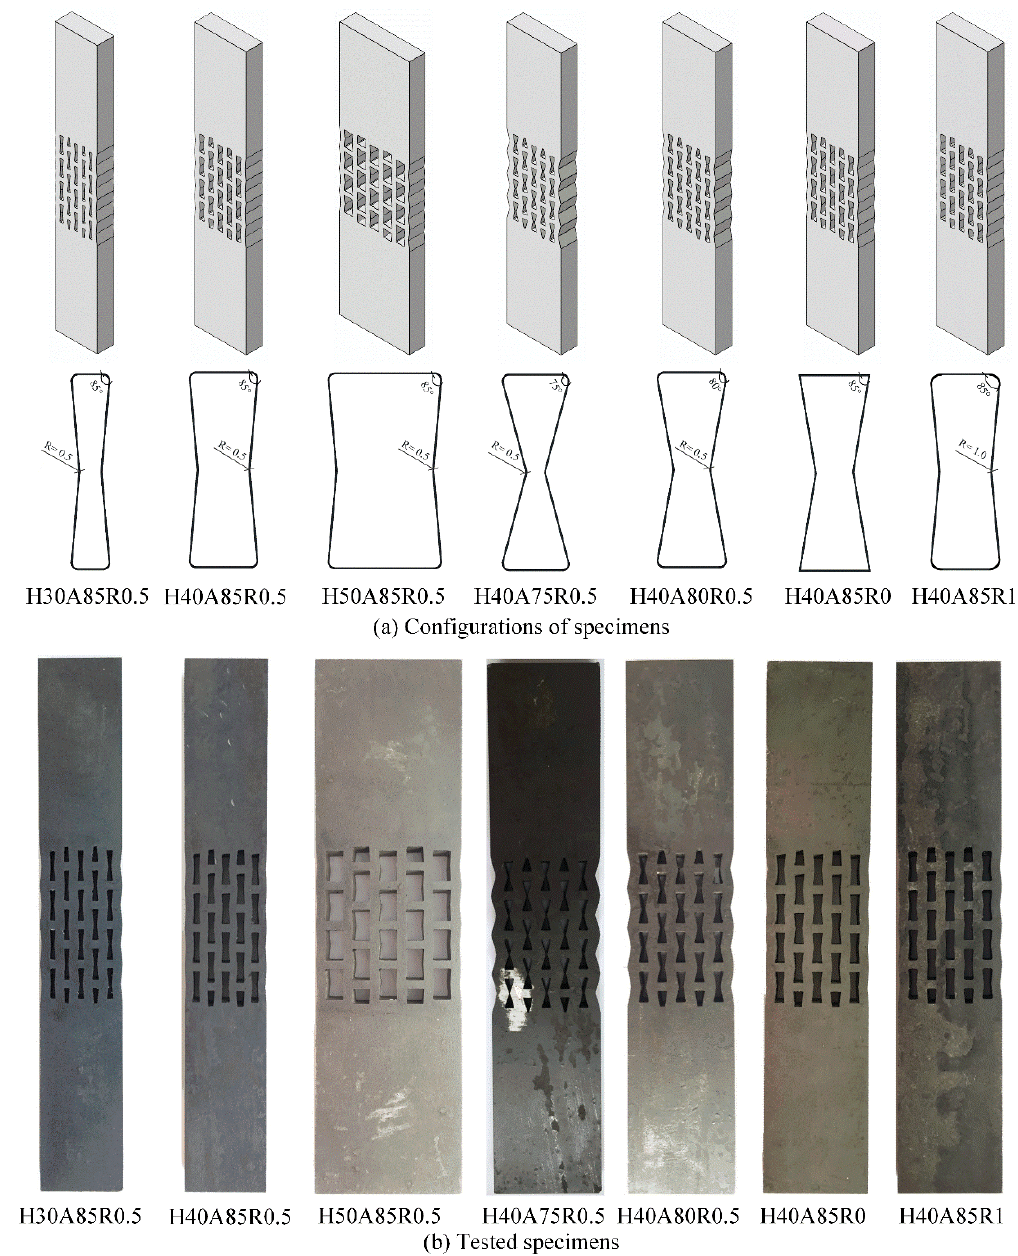
Figure 2. Design of tested specimens with ( a ) Configurations of specimens and ( b ) Tested specimens.